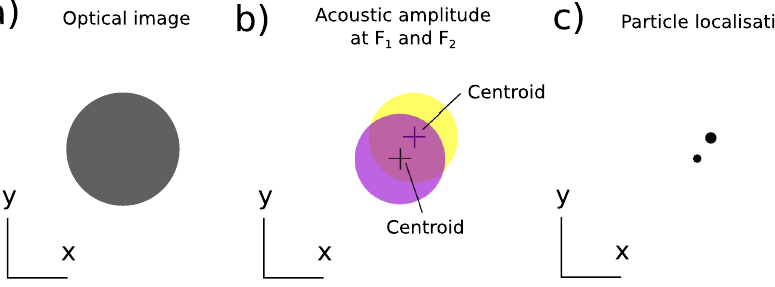
Figure 1. How nano-bells work. ( a ) Shows a representation of an optical image of metallic particles where the particles can not be resolved. ( b ) Shows a representation of an acoustic amplitude image of the same particles at a single frequency F 1 and F 2 . ( c ) Localisation of the particles from the centroids of the PSF of each frequency. The centroids obtained at frequencies F 1 and F 2 lead to the localisation of the particles with greater precision than the optical system used to image them. The size is obtained by the vibrational frequency of each